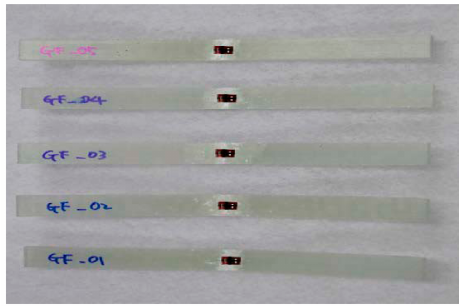
Figure 4. Fracture shape of compression